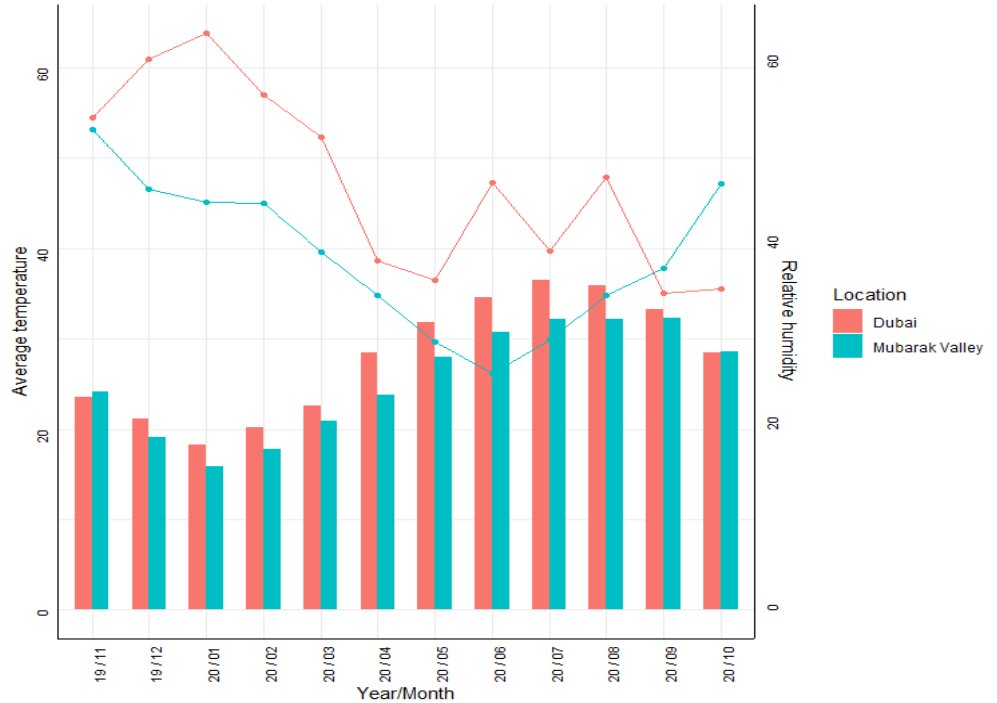
Figure 2. Average monthly temperature and relative humidity from November 2019 to October 2020 at ICBA in Dubai and Mubarak Valley in Marsa Alam. Data source: ERA5.